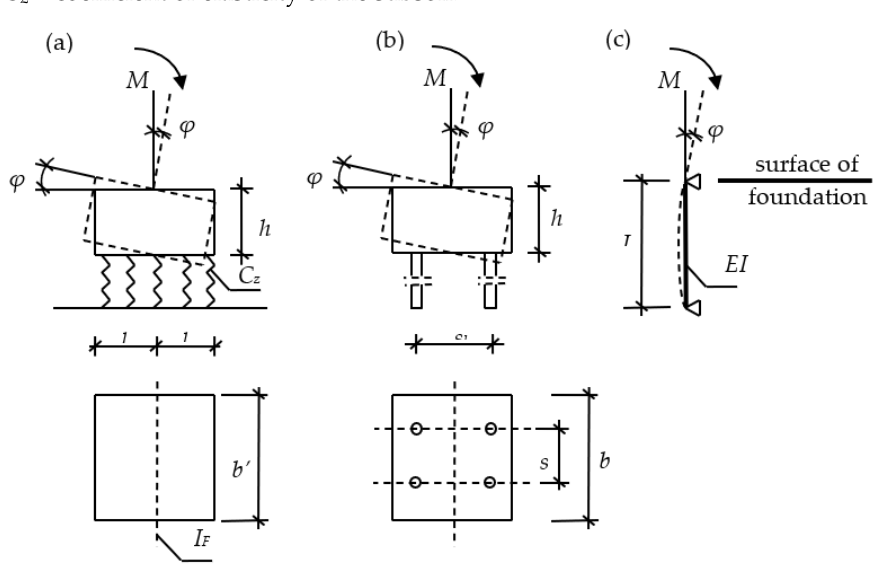
Figure 1. ( a ) Foundation on resilient ground; ( b ) pile foundation; ( c ) how ground influence is modeled in static calculations of foundations.